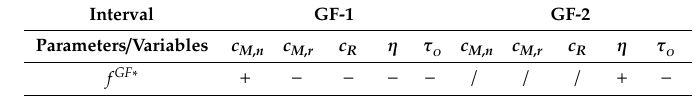
Table 6. Relationships between government unit tax and parameters for GF model.